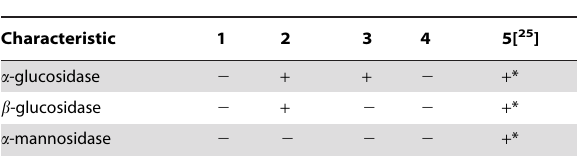
Table 2. Differential properties of the strain H4X T and related type strains of the genus Pontibacter.